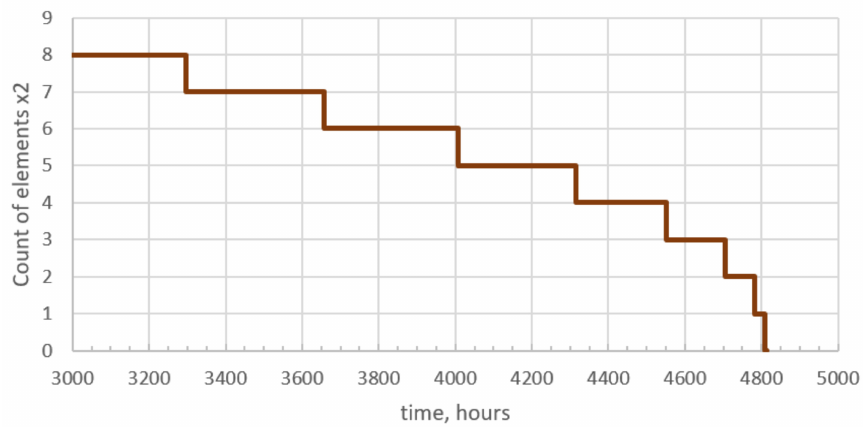
Figure 9. A fragment of a histogram of the hierarchical ramified system’s operation in the course of ( 1 ) = 6, a ( 2 ) = time for a 2 2